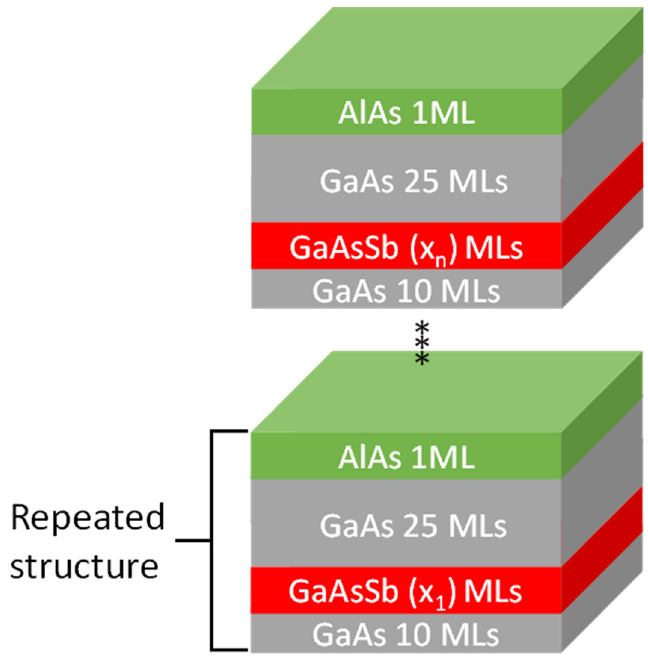
Figure 1. Basic diagram of the sample. Eight periods delimited by AlAs markers contain GaAsSb layers with thicknesses of 1, 2, 3, 5, 7, 10, 15, and 20 MLs enclosed between GaAs spacer layers (10 and 25